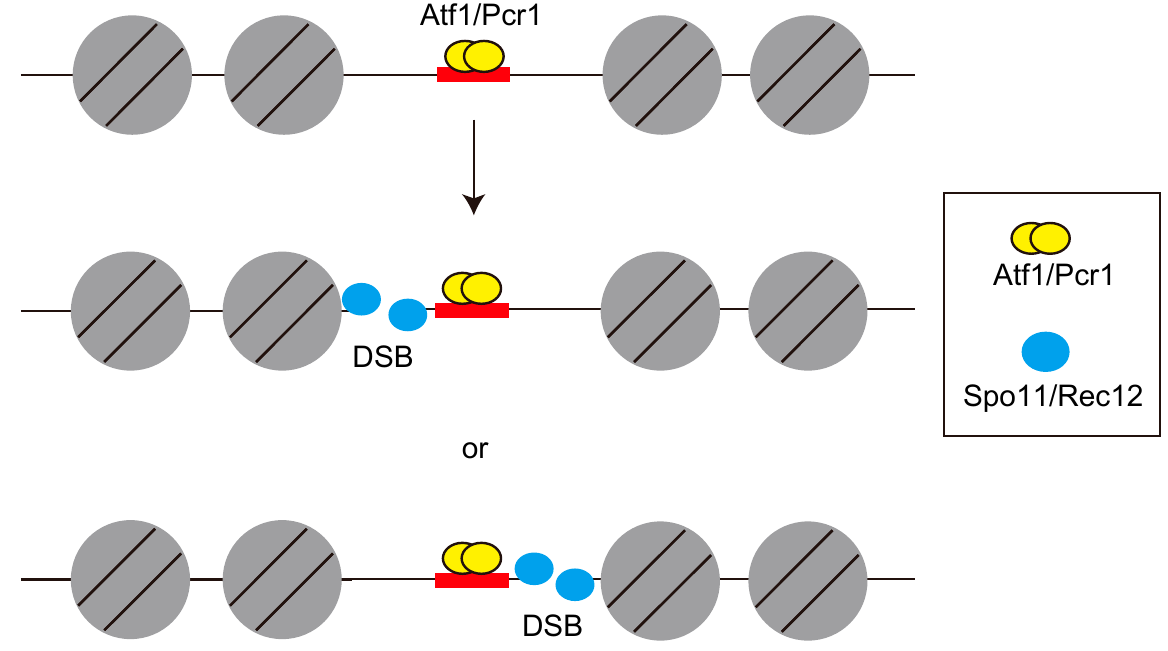
Figure 4. Schematic representation showing the position of DSBs within ade6 gene. The red box indicates the position of the CRE-like heptanucleotide sequence generated due to M26 mutation. DSBs were detected on both sides near the M26 mutation site surrounded by closely spaced M26 sites, whereas the M26 site itself lies in a region free of visible breaks.